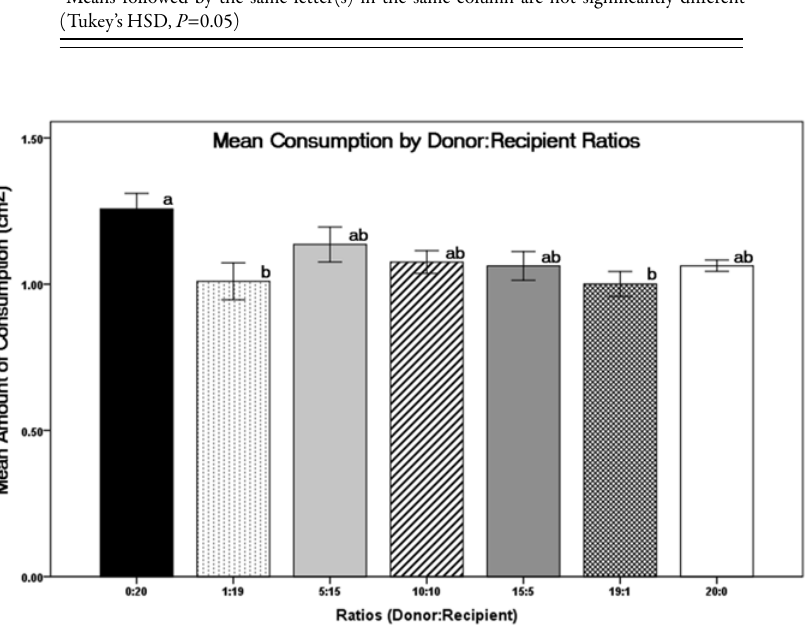
Fig. 4. Mean amount of consumption of substrate (cm2) by FST (donors and recipients) in each donor:recipient ratio through 7 d post-treatment. Bars with the same letter are not significantly different using Analysis of Variance (ANOVA) and Tukey’s HSD mean separation test at P <